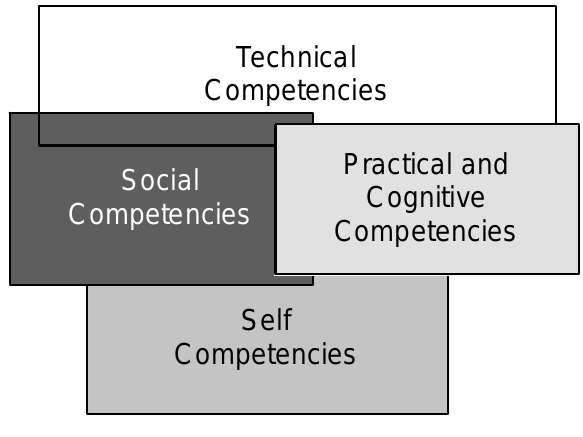
Figure 2. Competence